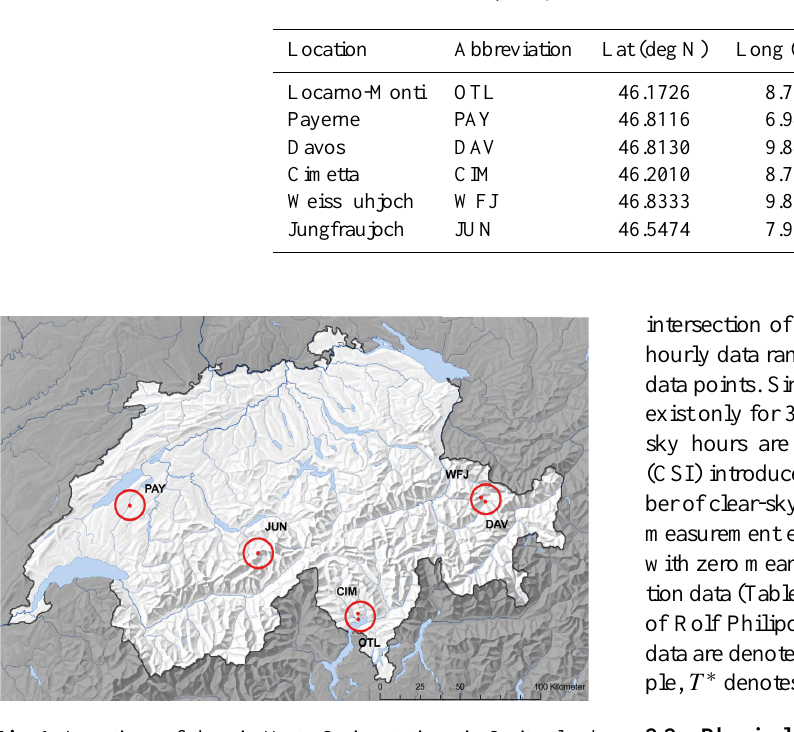
Table 1. Meta data of the MeteoSwiss stations. At each place, one ANETZ and one ASRB station is located.